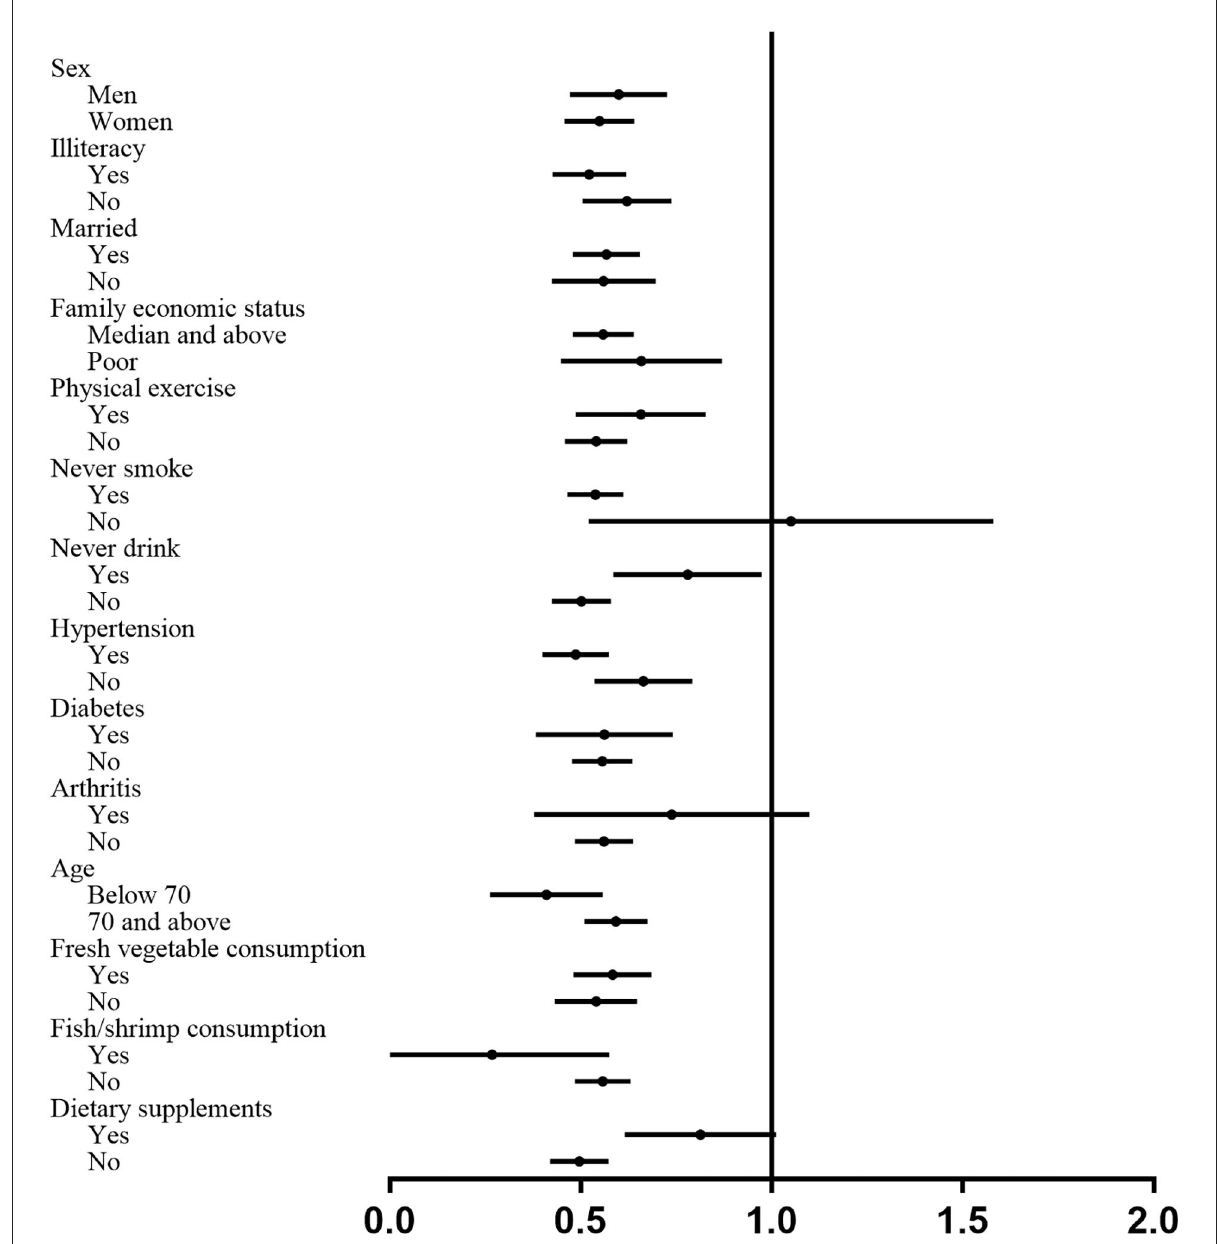
FIGURE1 Subgroup analyses of associations between soy product consumption and risk of the major depressive disorder according to potential baseline